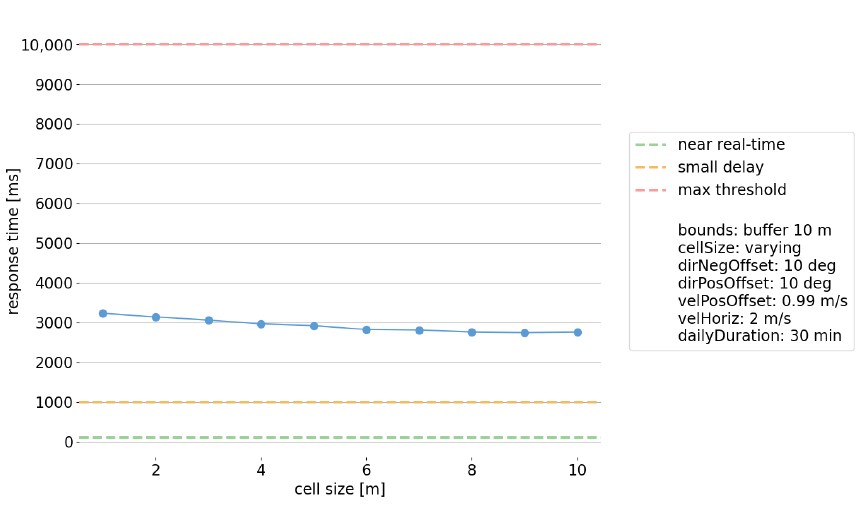
Figure 15. The response times when the grid cell